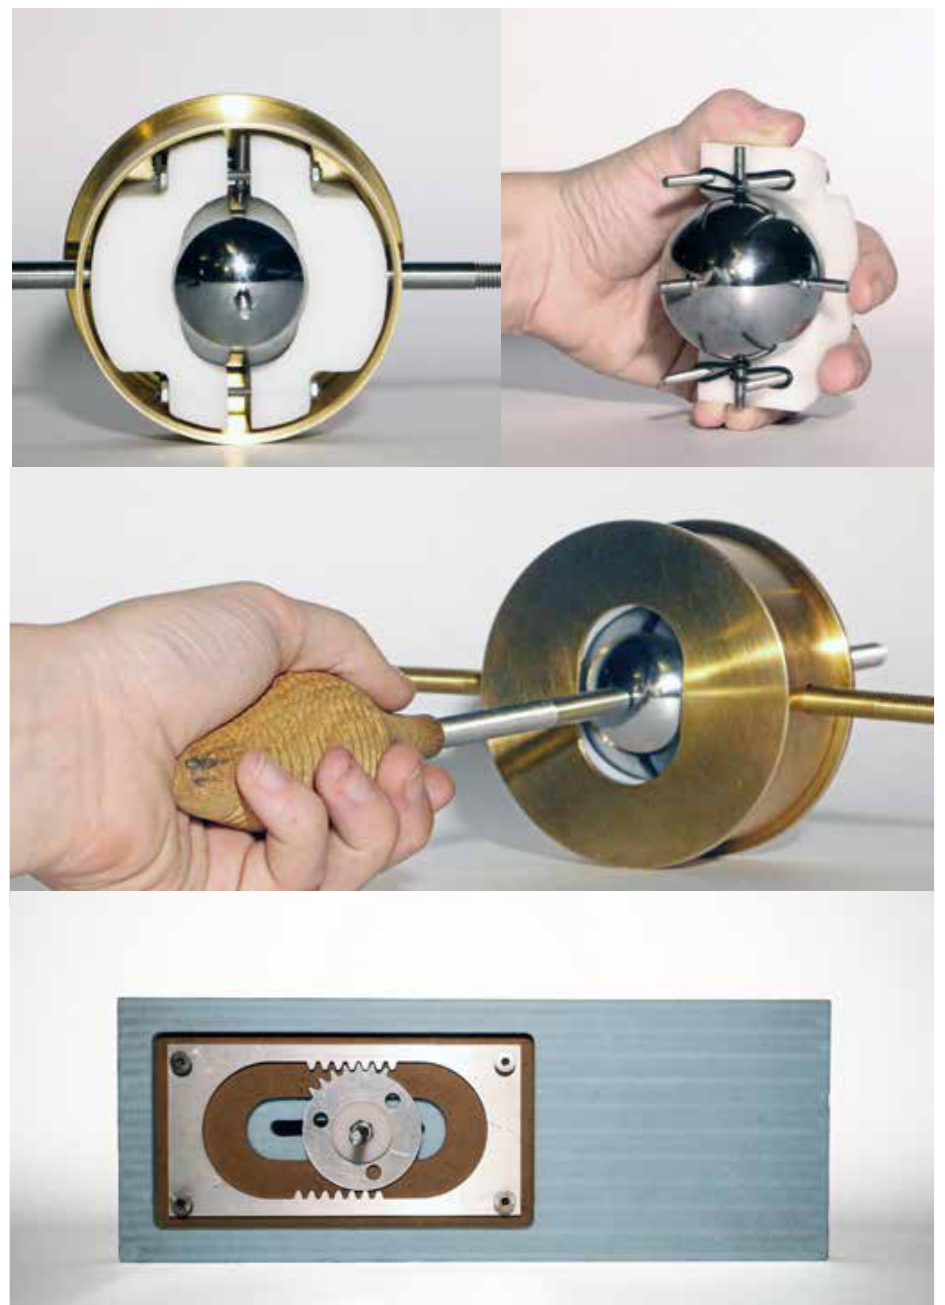
Figure 13: Operational expectations. Interior details of the spherical handshake and the mangle-rack latch , mechanisms which facilitate a multifaceted engagement while granting passage. Source: author.